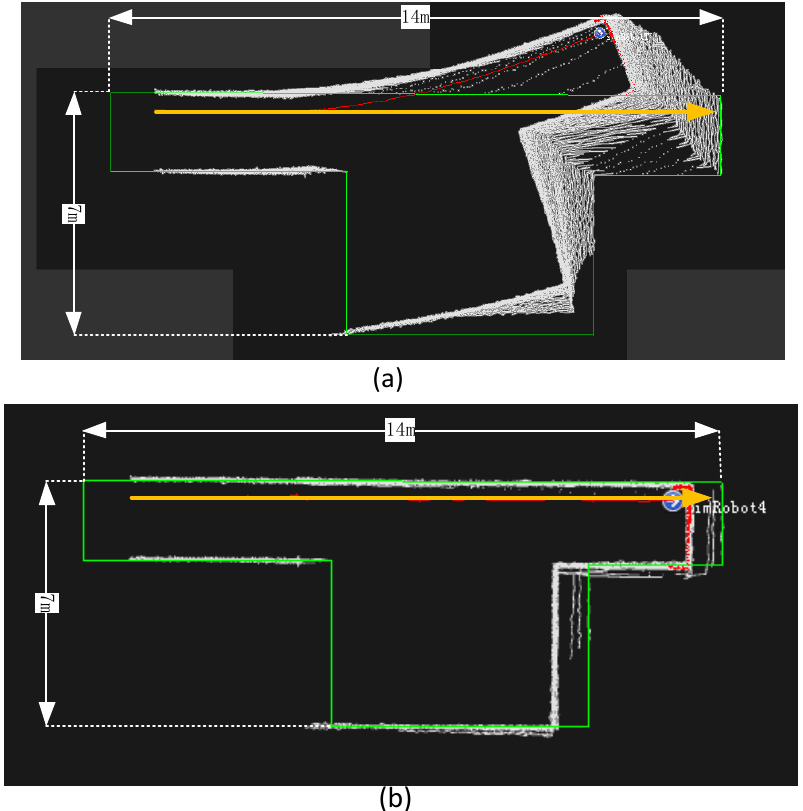
Figure 10. ( a ) The simulated result map with ICP at epoch 50; ( b ) The simulated result map with Monte Carlo at epoch 50; ( c ) The simulated result map with IMLE at epoch 50; and ( d ) Error comparison of ICP, Monte Carlo, and